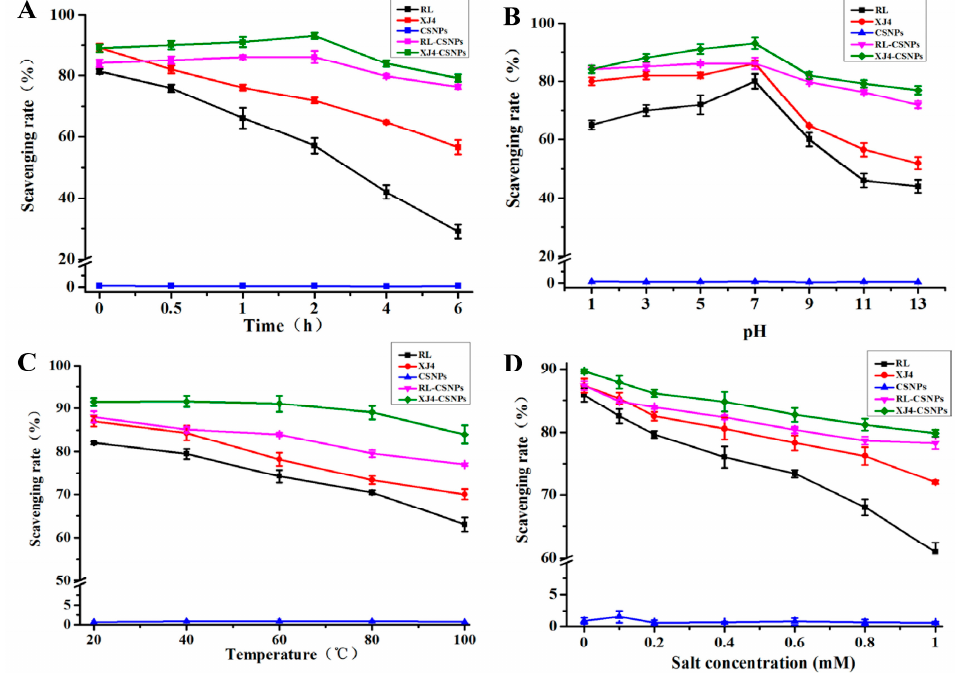
Figure 7. DPPH free radical scavenging ability of nanoparticles in different stress conditions. ( A ) Ultraviolet light exposure time; ( B ) pH; ( C ) temperature; ( D ) salt.